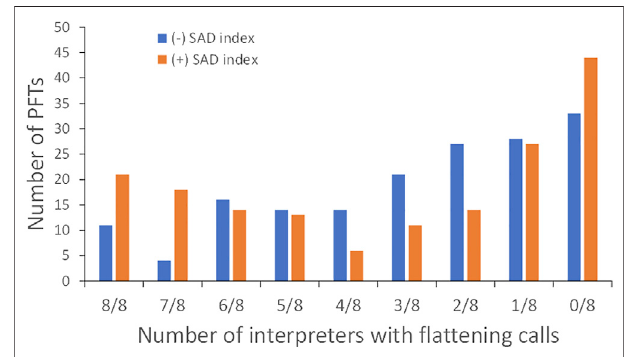
FIGURE 5 | Number of pulmonary function tests (PFTs) in which the interpreters agreed tothe presence ofthe fl atteningwith or without ∠ ABC, the small airway disease (SAD)